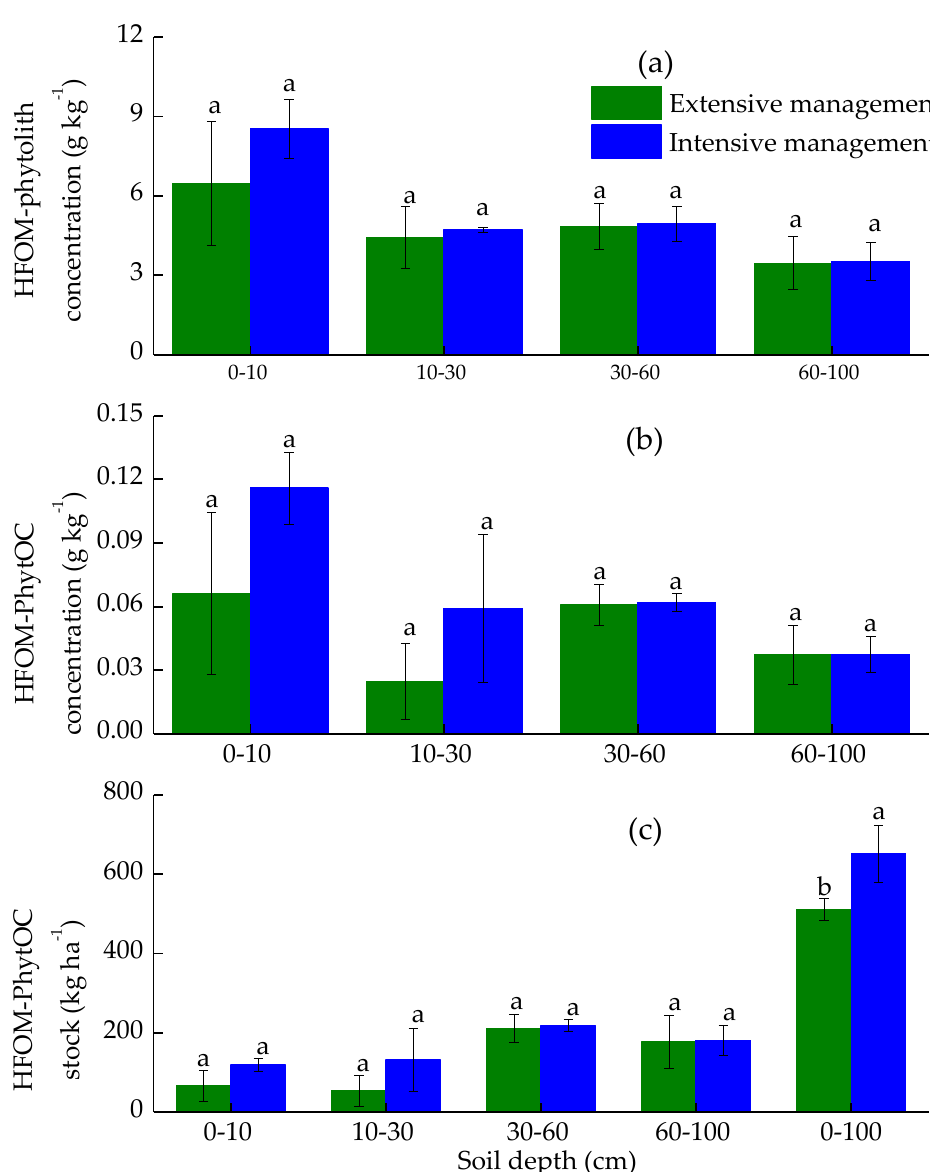
Figure 4. Heavy fraction organic matter ( a ) phytolith concentration, ( b ) PhytOC concentration and ( c ) PhytOC storage (mean ± SD, n = 3) of di ff erent soils layers from P. pubescens stands with di ff erent management intensities. Abbreviations: HFOM = Heavy fraction organic matter. Di ff erent letters within a column indicate significant di ff erences between the di ff erent management intensities within the same soil layer at the p = 0.05 level.